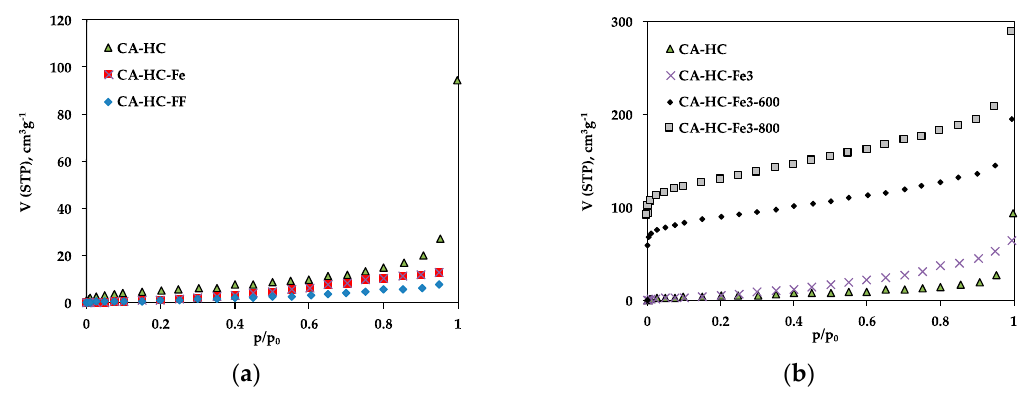
Figure 2. N 2 adsorption isotherms at –196 ◦ C of selected HCs: ( a ) CA–HC, CA–HC–Fe, and CA–HC–FF, Figure 2 . N 2 adsorption isotherms at –196 °C of selected HCs: ( a ) CA – HC, CA – HC – Fe, and CA – HC – and ( b ) CA–HC, CA–HC–Fe 3 , CA–HC–Fe 3 -600, and CA–HC–Fe 3 FF, and (b) CA – HC, CA – HC – Fe 3 , CA – HC – Fe 3 -600, and CA – HC – Fe 3 -800 . Table 3. Textural parameters of the HCs as deduced from N 2 adsorption at − 196 °C.